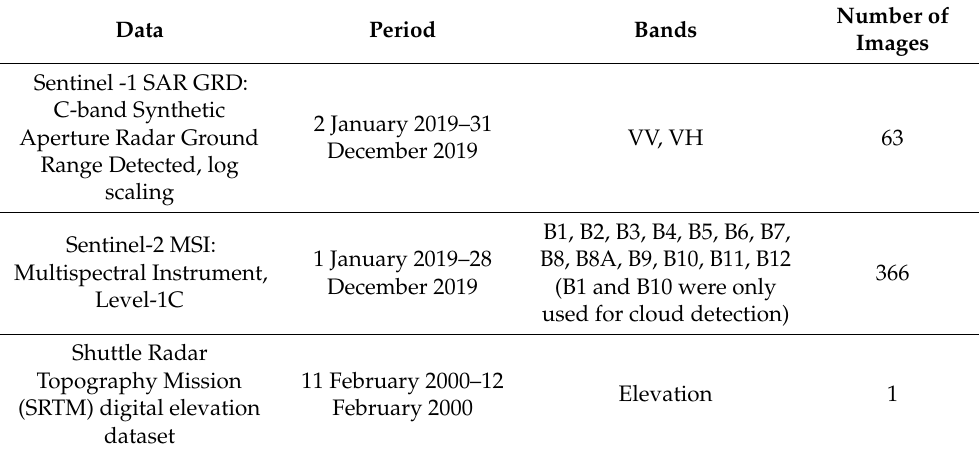
Table 1. Satellite remote sensing data used for Greater Amanzule land cover